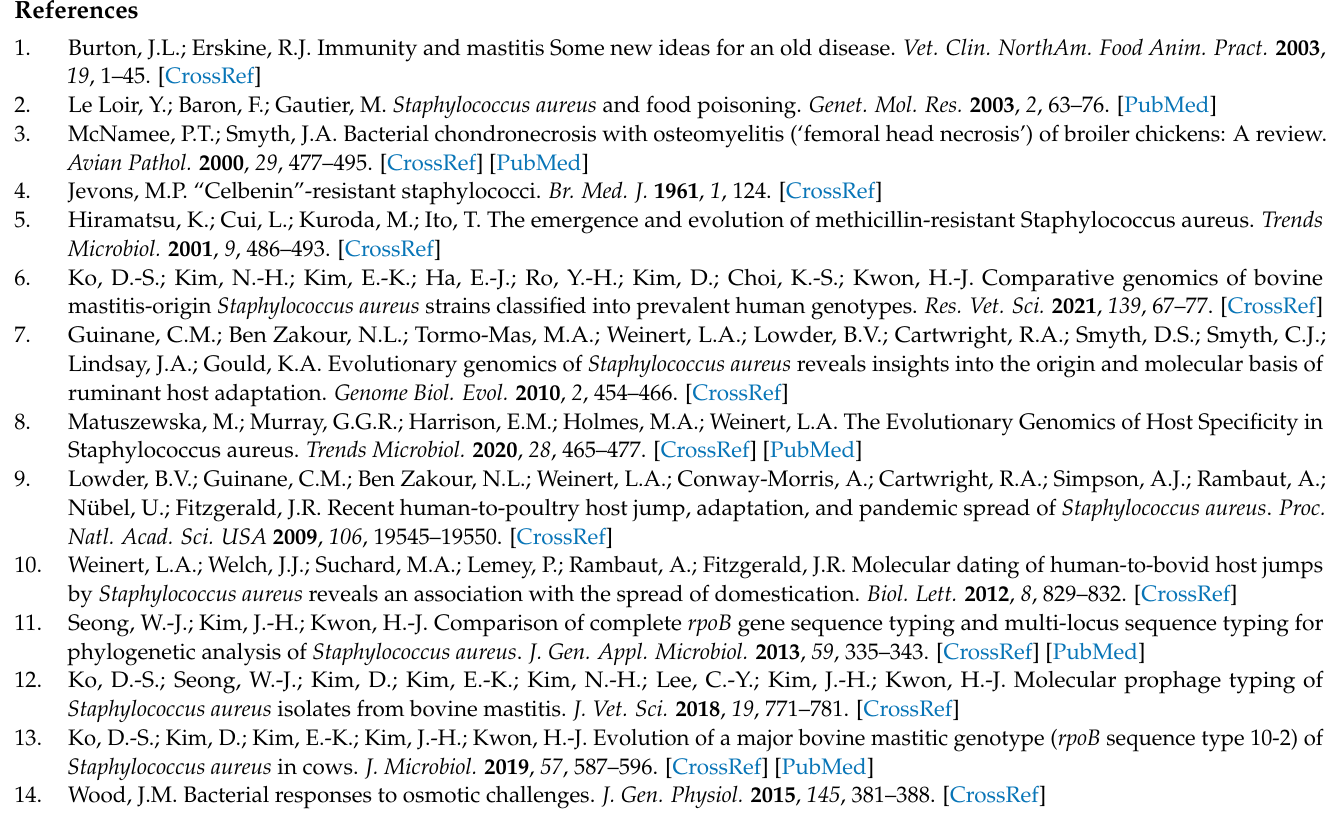
Table S3. PCR primers used for amplification of DNA templates for cell-free expression; Table S4. PCR primers used for ALS2 mutagenesis; Table S5. PCR primers used for transmembrane region deletion; Table S6. PCR primers used for mutagenesis of ALS2 89th amino acid